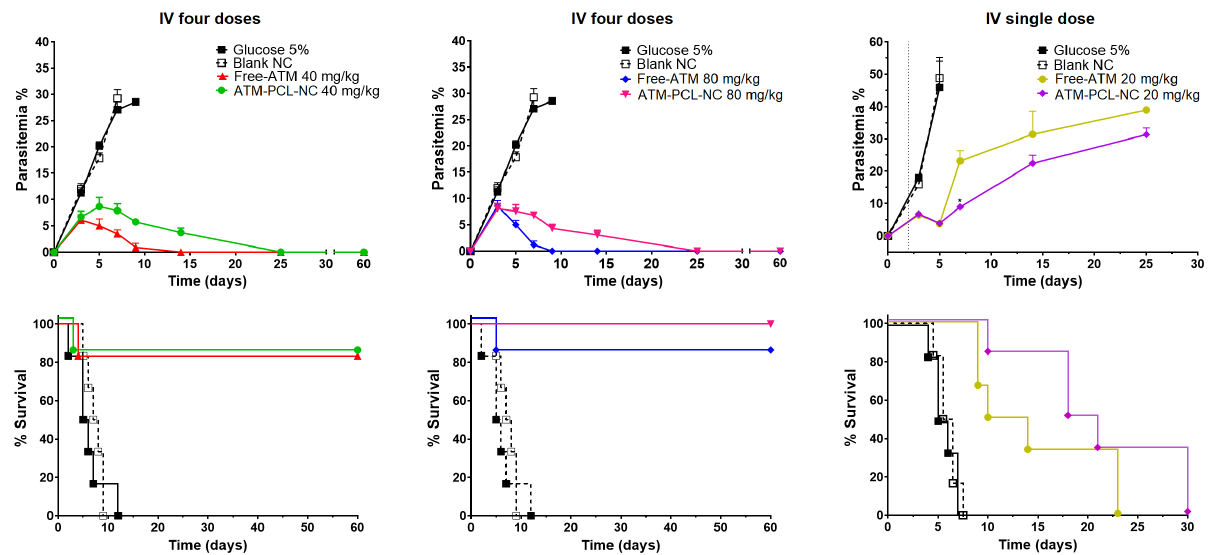
Figure 4. Efficacy of the artemether formulations represented in graphs of parasitemia (%) and survival (%) for both protocols (four-day-test) and single low dose (20 mg/kg) with established parasitemia (15%).